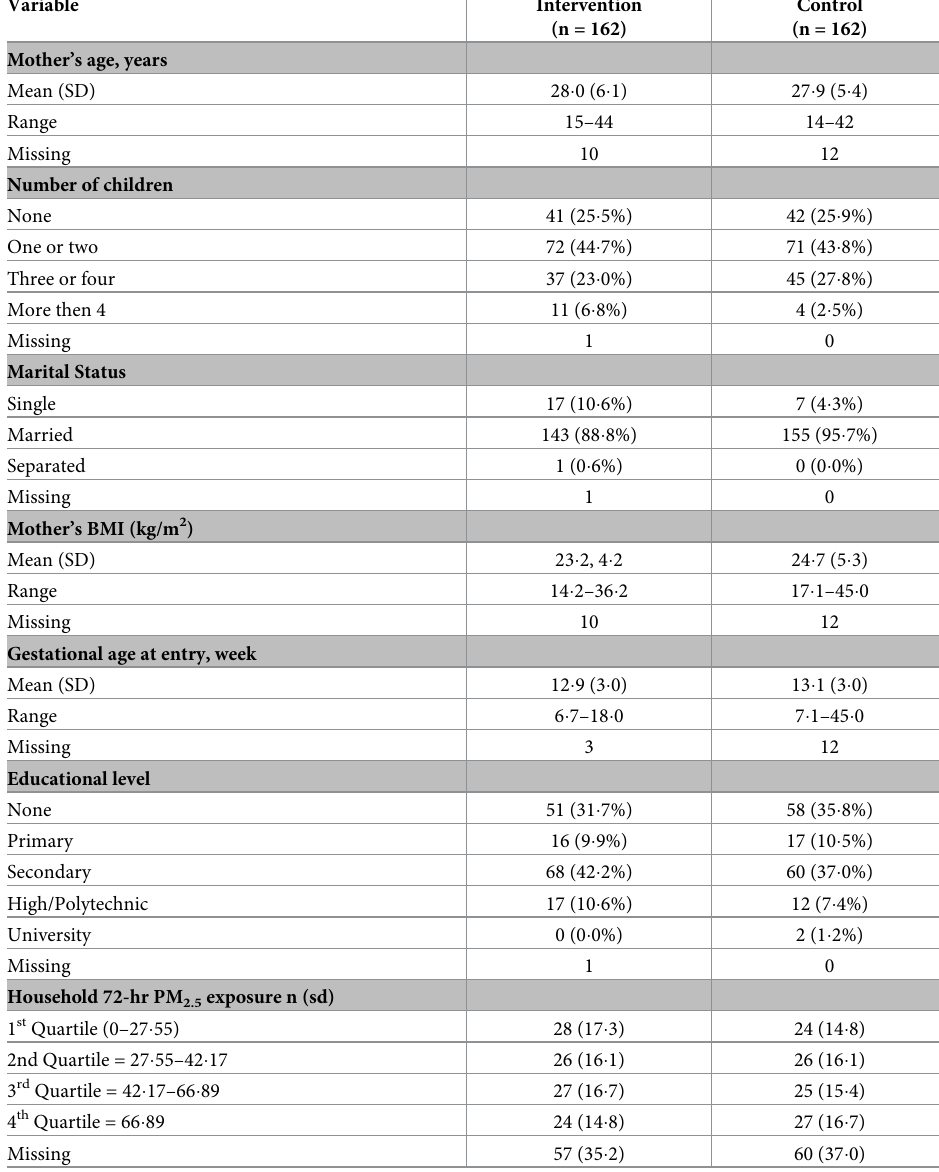
Table 1. Baseline demographic and clinical characteristics, by intervention